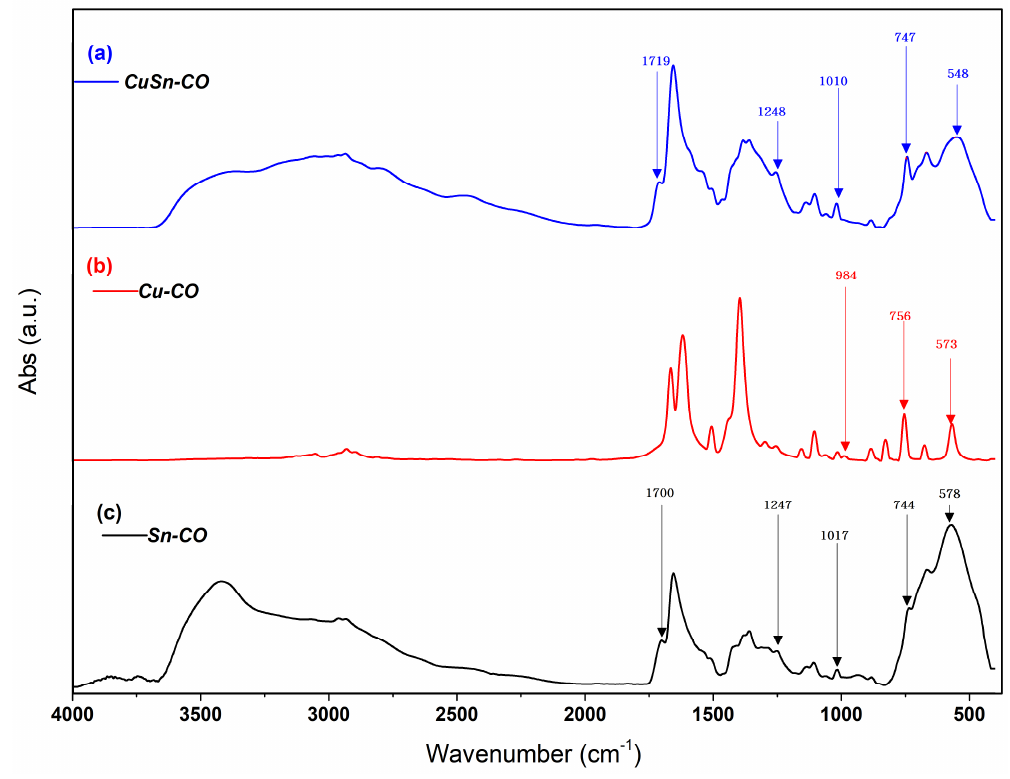
Figure 4. FTIR spectra of as-synthesized ( a ) Cu-OC, ( b ) Sn-OC, and ( c ) CuSn-OC. The band at about 3509 cm −1 for the carboxylic acid virtually disappeared from the spectra of the prepared OC samples. The OC samples exhibited a more broadened band in the region near 2970–2980 cm −1 , indicating the presence of coordinated water molecules. The coordinated water in all the oligomeric metal (II) complexes presented different peaks at 1000 cm −1 (rocking) and 750 cm −1 (wagging), whereas none of these vibrations appeared in the spectra of uncoordinated ligands [29].